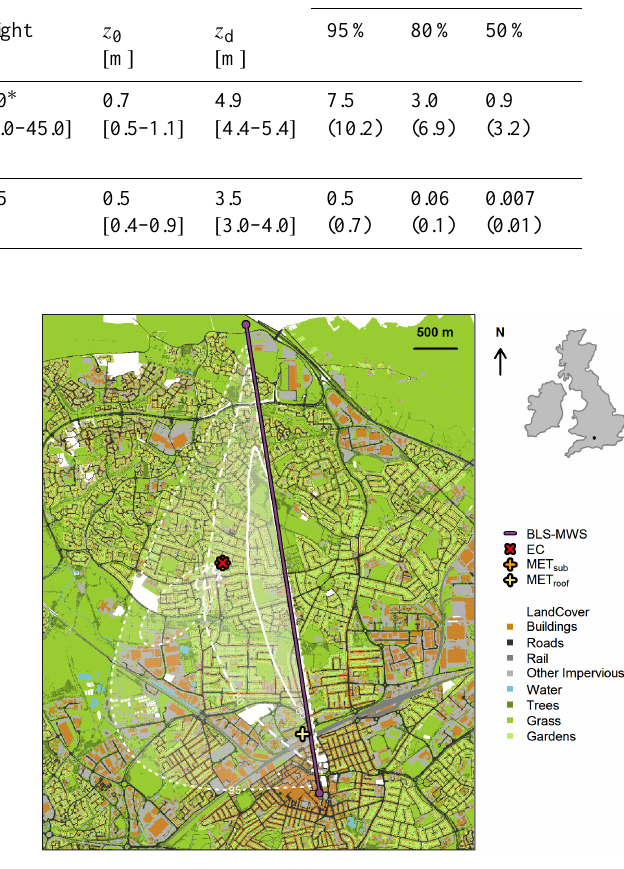
Figure 2. Land cover map of the study area showing the two- wavelength scintillometer path (BLS–MWS) and locations of the eddy covariance station (EC) and two meteorological sta- tions (MET sub , MET roof ). Land cover classification was based on a geodatabase (OS MasterMap 2010 © Crown Copyright), li- dar data (2007, © Infoterra Ltd) and aerial photography (2009, © GeoPerspectives). Where data were unavailable, areas are left un- classified (white). Example footprints indicate the area contribut- ing 50, 80 and 95% of the observed fluxes for typical unstable at- mospheric conditions and southwesterly wind (see text for details). The location of Swindon within the British Isles is shown (top right